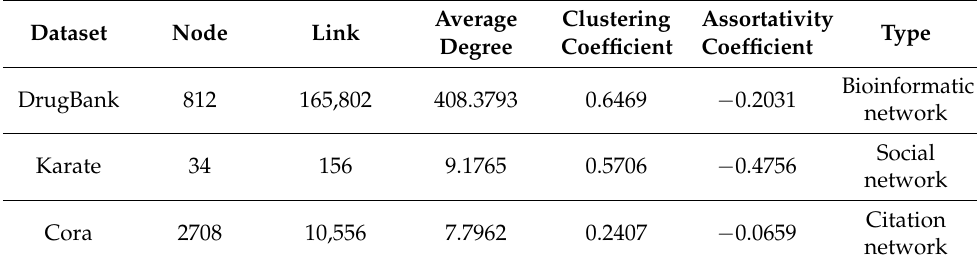
Table 1. The characteristics of the three experimental